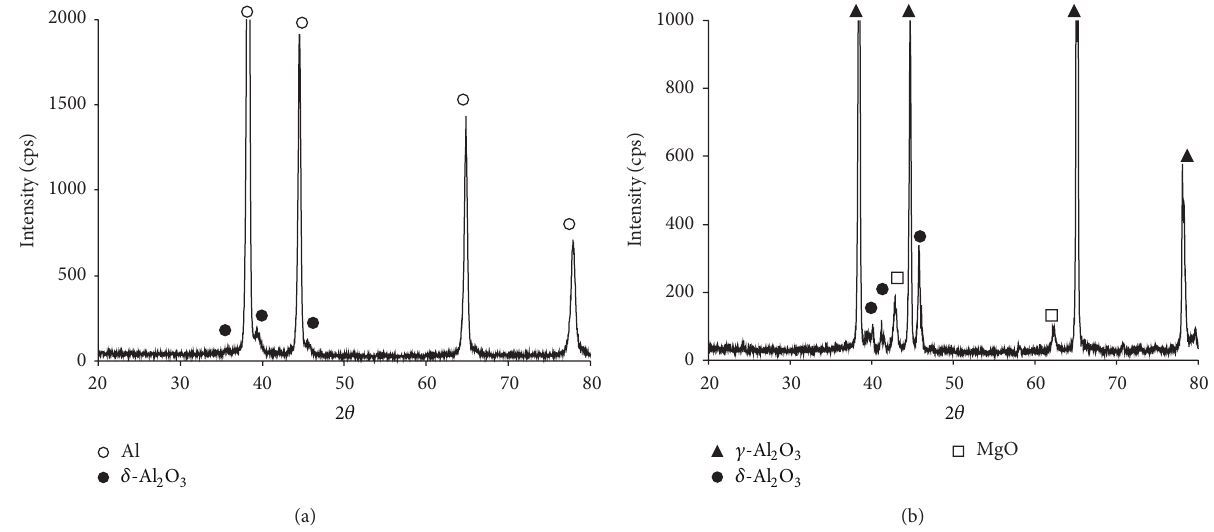
Figure 8: XRD diffractograms of fused metal surface of welded AA6061 Al alloy, (a) before and (b) after being subjected to oxidation test for 40 hours at temperature of 600 ∘